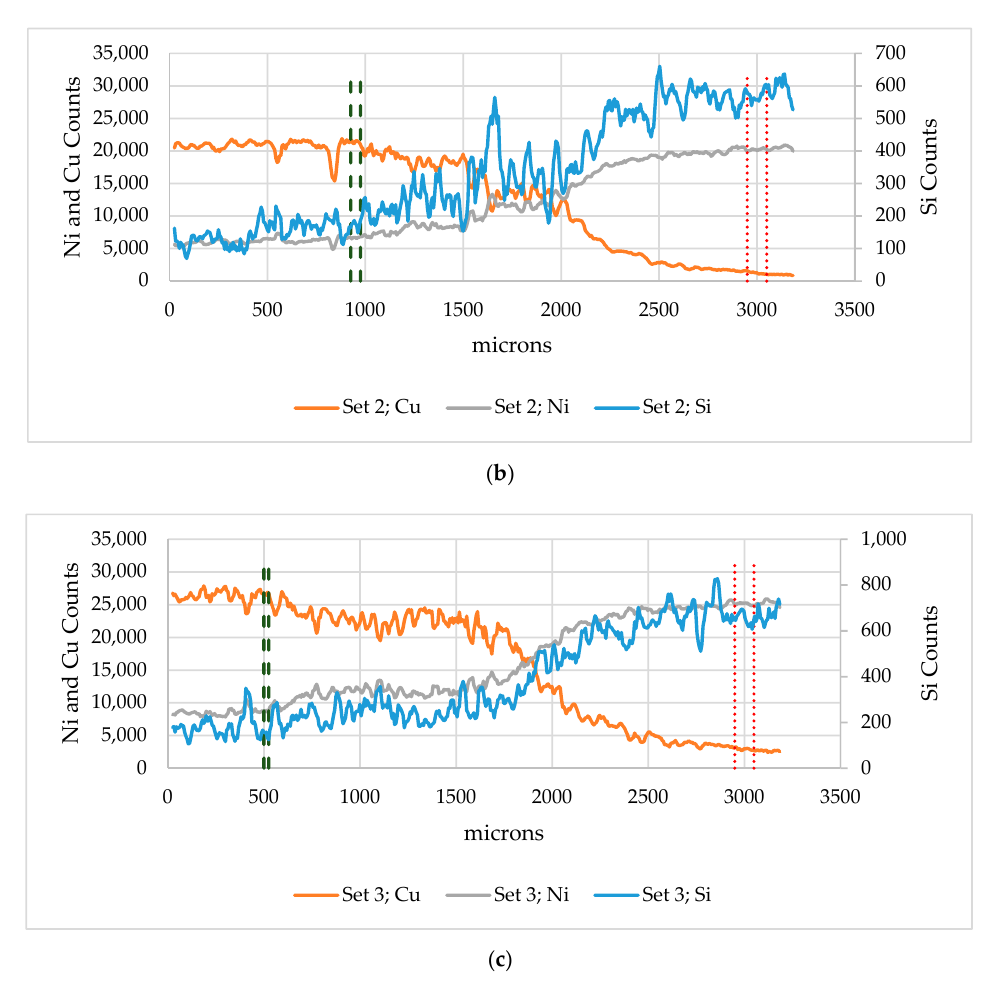
Figure 11. EDS line scan analyses across dissimilar graded material interfaces for the three sets, ( a ) set 1, ( b ) set 2 and ( c ) set 3, of duty cycle ramp downs (see Figure 2) when 100/0 nickel-rich deposit was fabricated on 30/70 copper-rich pre-deposit. Dashed lines indicate the approximate locations of start (dark green) and end (bright red) points of the transition region.